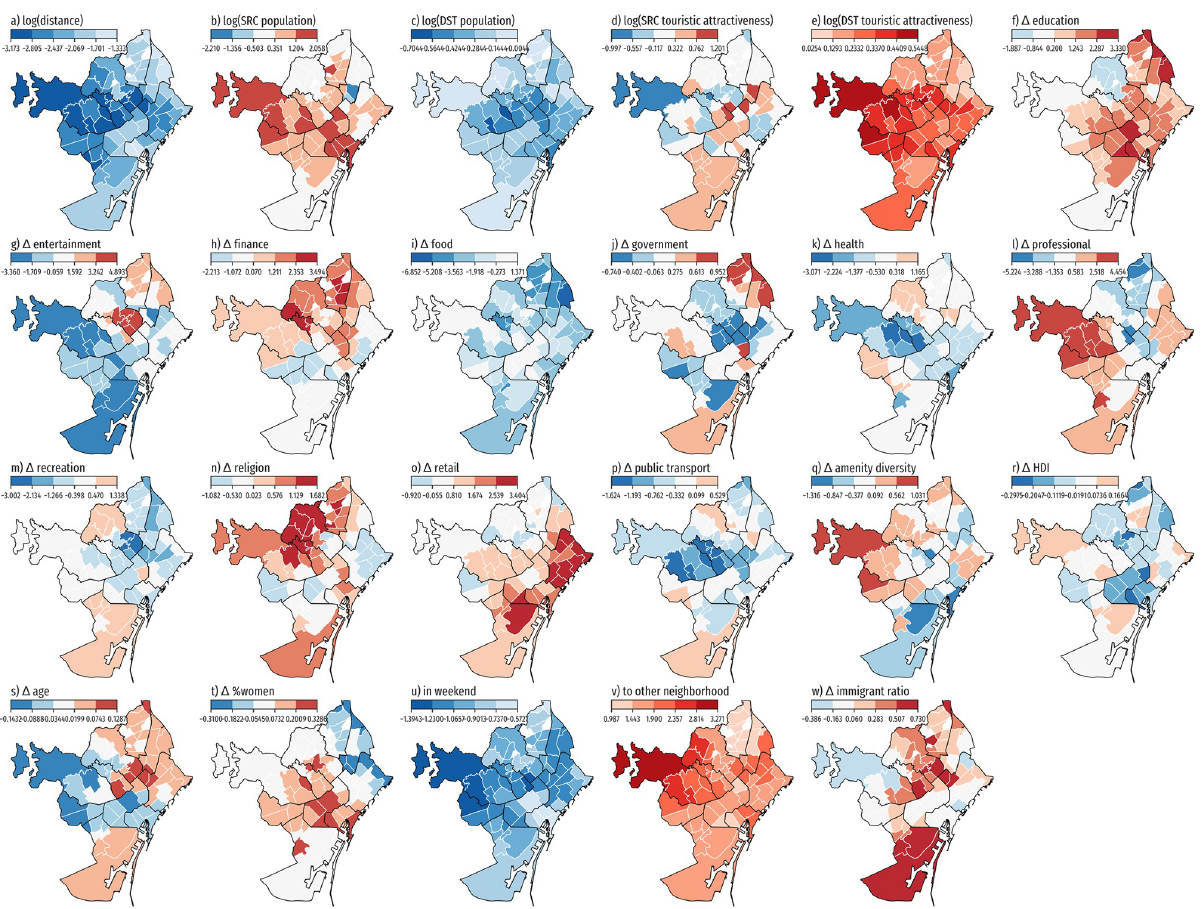
Fig 5. Spatial distribution of the local regression factors from the GWR model. Each choropleth map uses a color scale with red tones to depict positive values, and blue tones to depict negative values. Factors: a) Distance. b) Neighborhood Population. c) Destination Population. d) Neighborhood Touristic Attractiveness. e) Destination Touristic Attractiveness. f) Δ education . g) Δ entertainment . h) Δ finance . i) Δ food . j) Δ government . k) Δ health . l) Δ professional . m) Δ recreation . n) Δ religion . o) Δ retail . p) Δ public transport . q) Δ neighborhood amenity diversity . r) Δ neighborhood Human Development Index (HDI). s) Δ neighborhood mean age . t) Δ % women population . u) weekend flag (binary). v) visiting other neighborhood (binary). w) Δ ratio immigrants to nationals . Administrative boundaries are sourced from CartoBCN under a CC BY 4.0 license, with permission from Ajuntament de Barcelona , original copyright 2020.